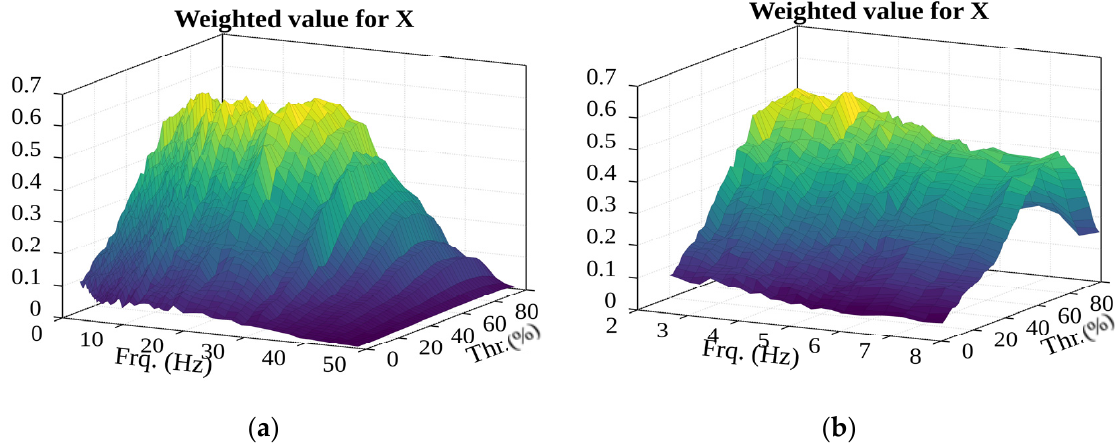
Figure 28. Second evaluation of the surface of the weighted value of potential events and RMS (in the ( a )—2.6–49 Hz; ( b )—2.6–8 Hz frequency range).